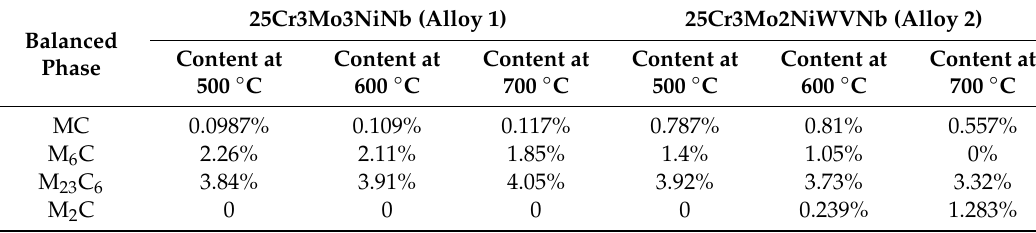
Figure 7. Comparison of carbides—both materials. Table 6. Comparing the information calculated from the balance phase of alloy 1 and alloy 2.